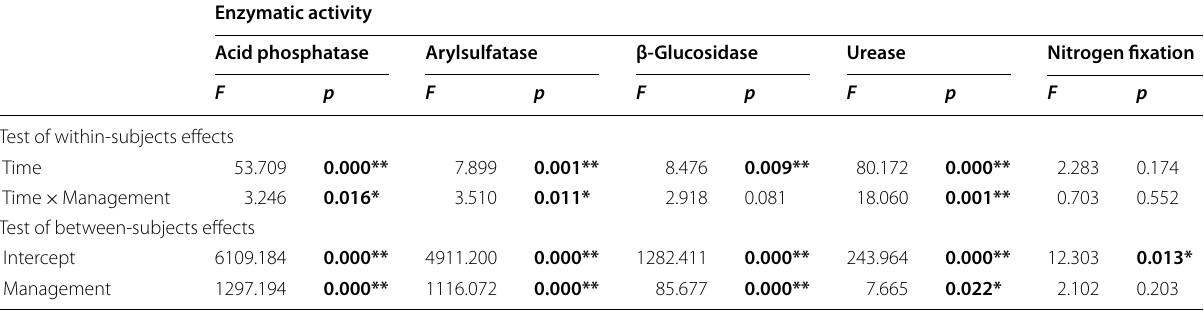
Table 1 Statistical significance (p‑value) for repeated measures ANOVA on acid phosphatase, arylsulfatase, β‑glucosidase, urease, and nitrogen‑fixing